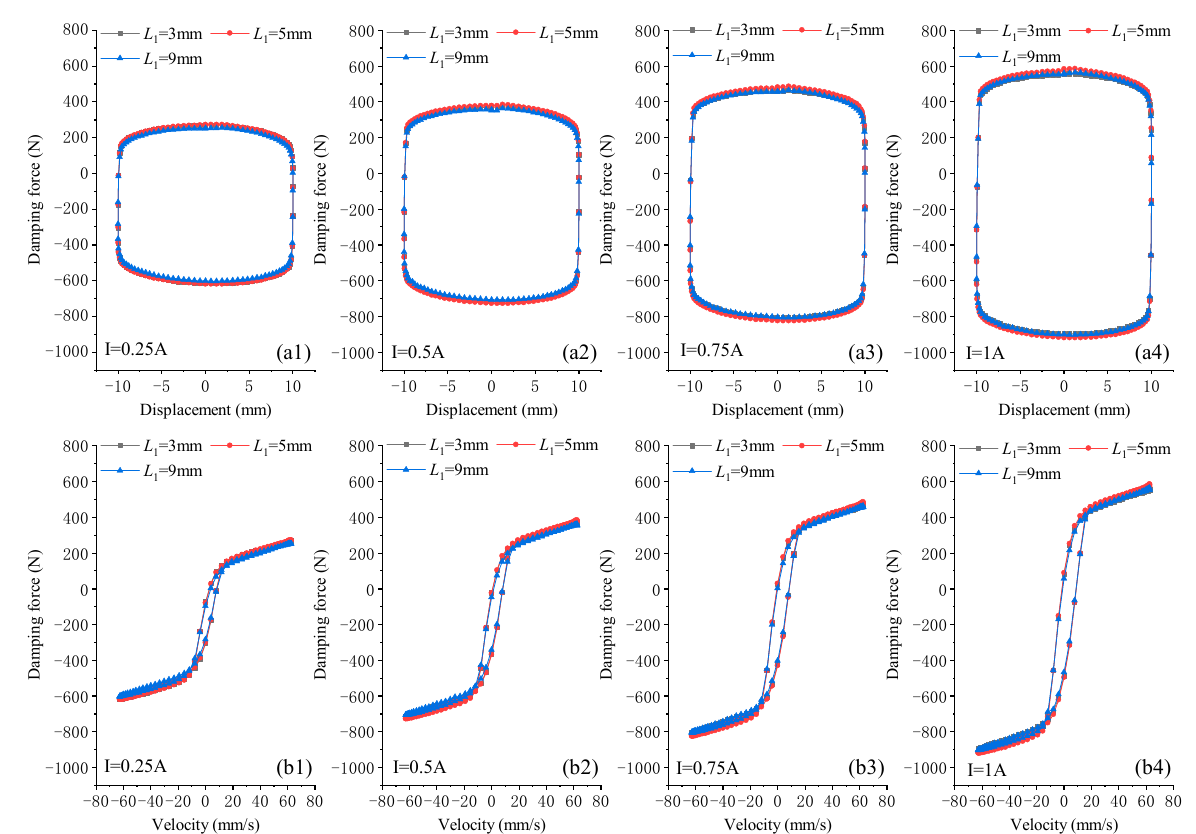
Figure 12. Damping characteristics of effective magnetic poles at different ends for I = 0.25, 0.5, 0.75 and 1 A: ( a1 – a4 ) damping force–displacement; and ( b1 – b4 ) damping force–velocity.